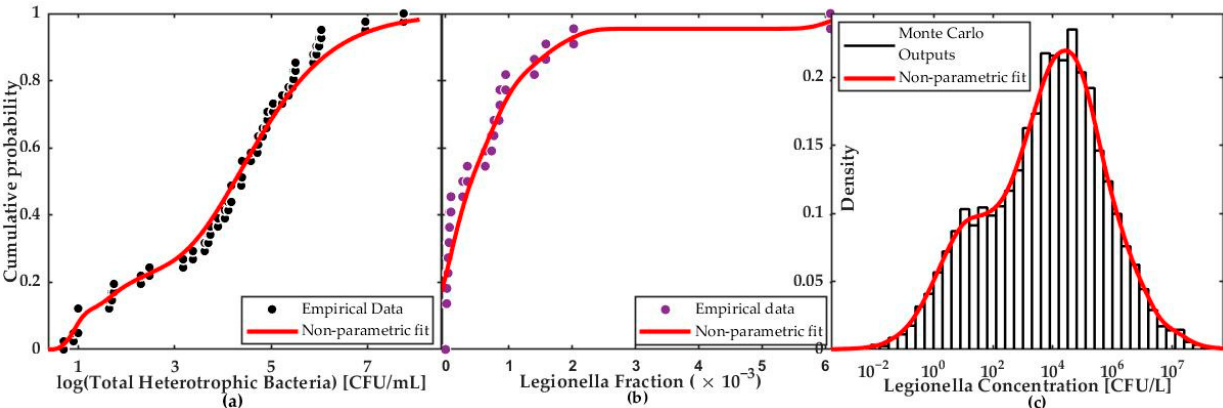
Figure 3. Non-parametric cumulative distribution fits of total heterotrophic bacterial data in cisterns ( a ), the fraction of Legionella bacteria among total microbial community in cisterns ( b ), and Monte Carlo simulation outputs of Legionella concentration in cisterns of St. Thomas, Virgin Islands ( c ). Empirical data for ( a ) and ( b ) were collected by Crabtree et al. (1999) [19] and Jiang et al. (2020) [9], respectively.